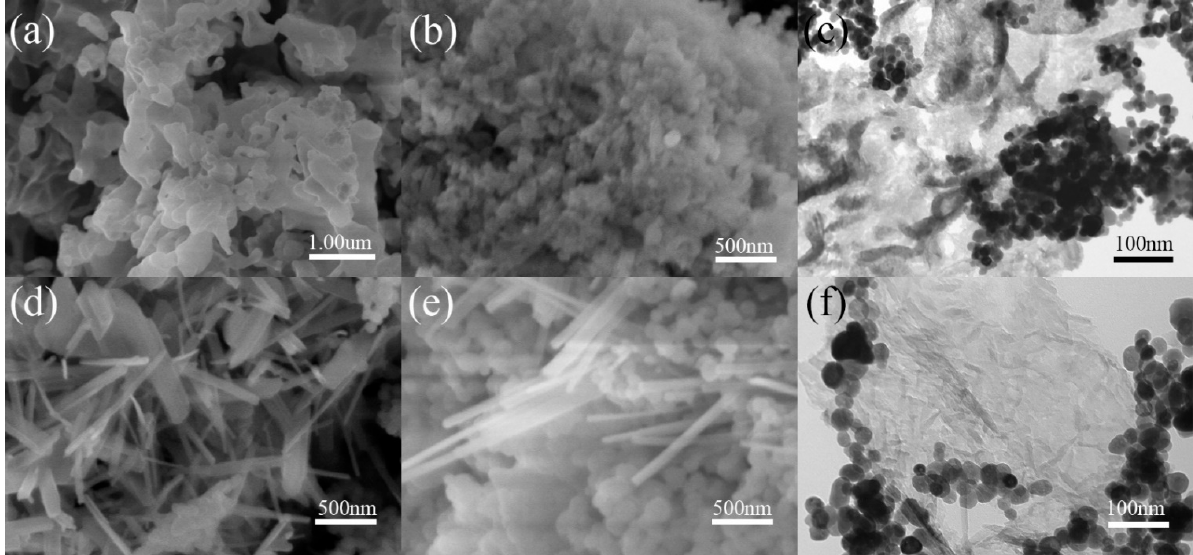
Figure 2. The SEM images of ( a ) g-C 3 N 4 , ( b ) GdVO 4 , ( d ) LaVO 4 , and ( e ) LaVO 4 /g-C 3 N 4 and the TEM images of ( c ) GdVO 4 /g-C 3 N 4 and ( f ) LaVO 4 /g-C 3 N 4.